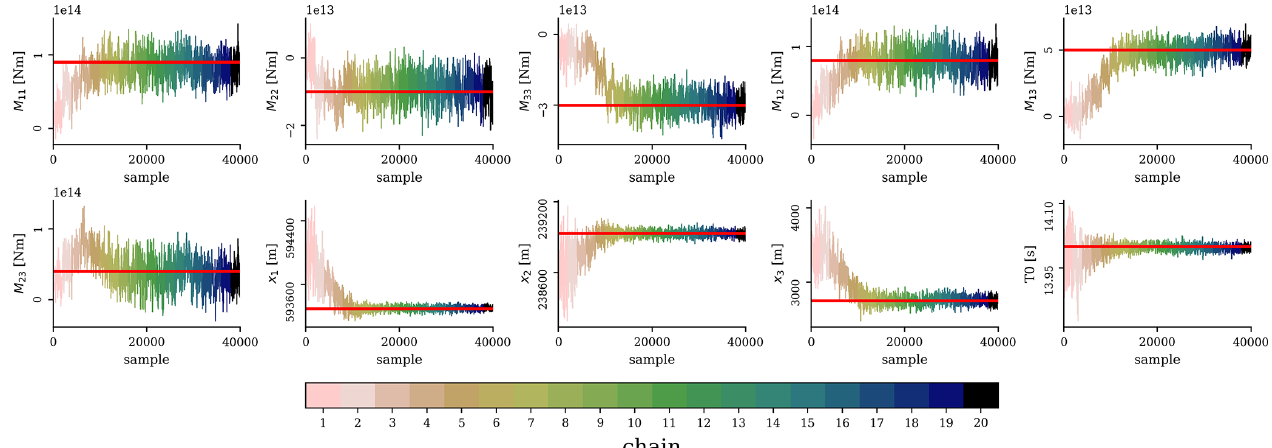
Figure 5. Full workflow of our iterative HMC scheme.